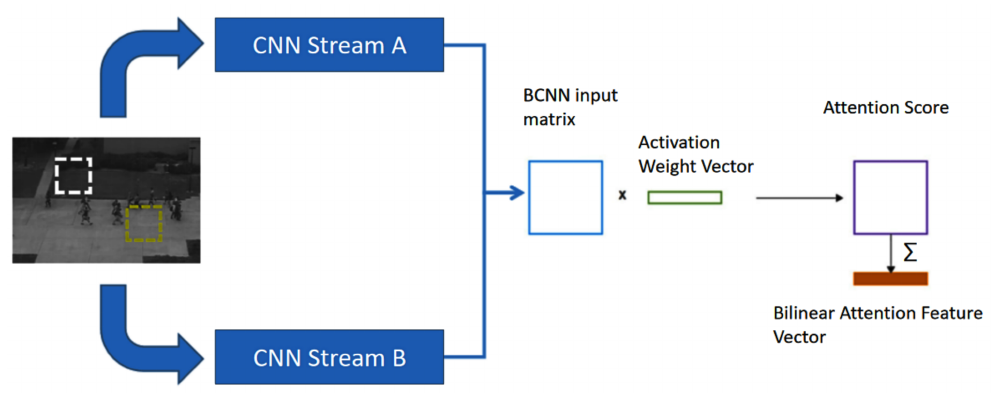
Figure 2. Bilinear attention flow